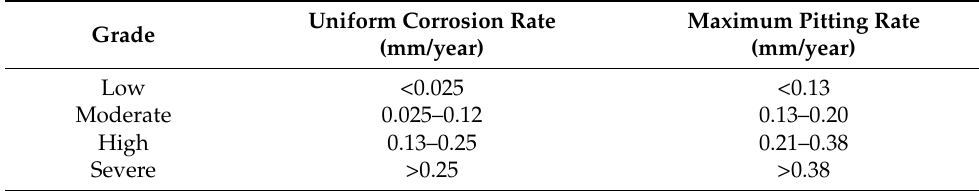
Table 6. Corrosion grade for the oil production system.